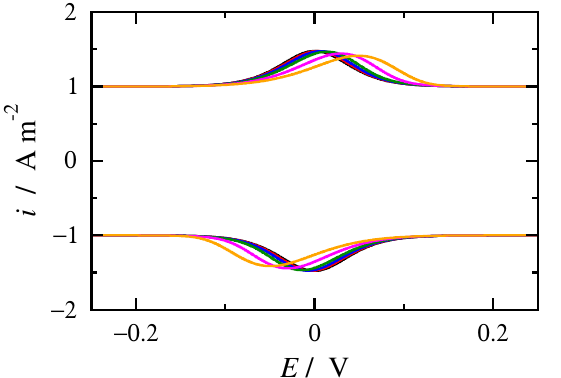
Figure 2. Computational results: Cyclic voltammetry for different k 0 values. Parameter values: Γ 0 = 5.1 × 10 − 6 mol m − 2 , C = 1 F m − 2 , E 0 (cid:48) = 0 V, v = 0.1 V s − 1 and k 0 = 100 (black), 20 (red), dl 10 (blue), 5 (green), 2 (orange) and 1 s − 1 (orange). Table 1. Peak separation values for an immobilised species assuming v = 0.1 V s − 1 and ideal capacitance. k 0 /s −